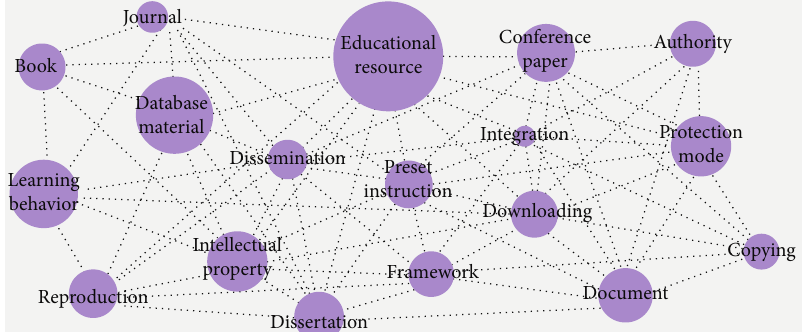
Figure 2: Intellectual property expression systems of educational resource data based on machine learning.